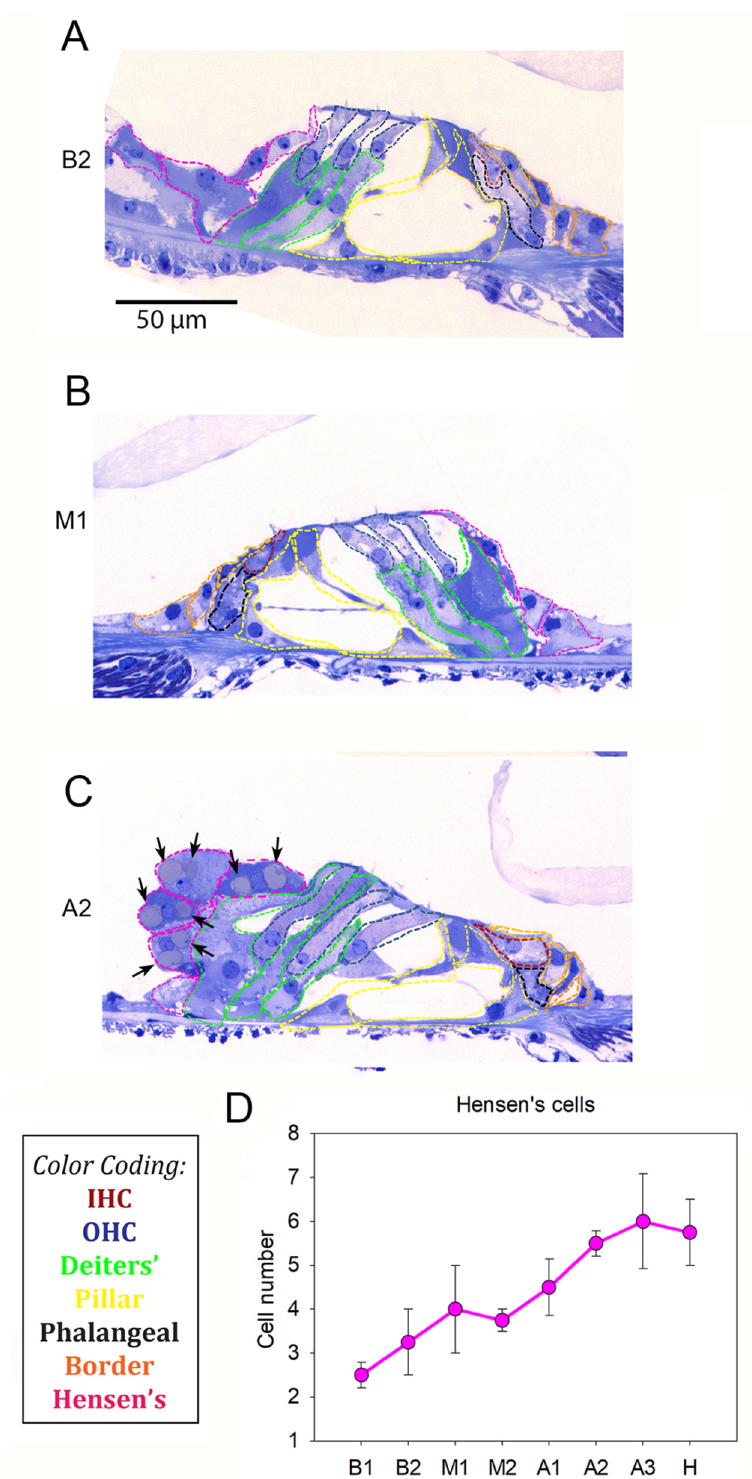
Figure 3. The organ of Corti in normal-hearing guinea pigs. Representative images of a ( A ) B2, ( B ) M1 and ( C ) A2 turn from a NH guinea pig cochlea. Hair cells and supporting cells were marked by using the color coding reported in the black frame: inner hair cells (red), outer hair cells (blue), Deiters’ (green), pillar (yellow), phalangeal (black), border (orange) and Hensen’s (pink). The black arrows indicate the vacuoles present in the Hensen’s cells of the apical turn. ( D ) Hensen’s cell count along the cochlear turns of NH guinea pigs shows an increase from base to apex, visualized as mean ± SEM, as also clearly visible from the images.